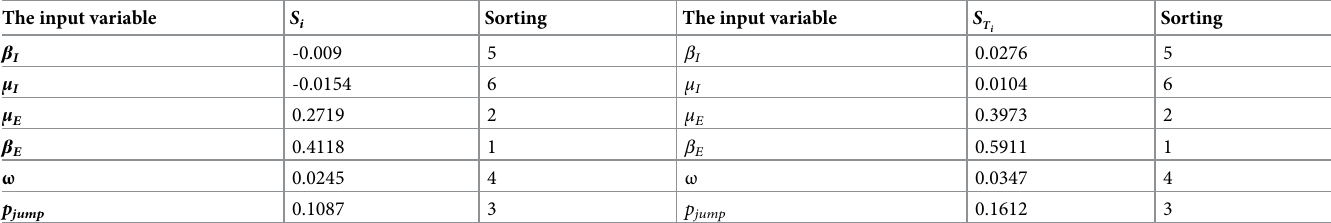
Table 5. Sensitivity index of each variable to ρ